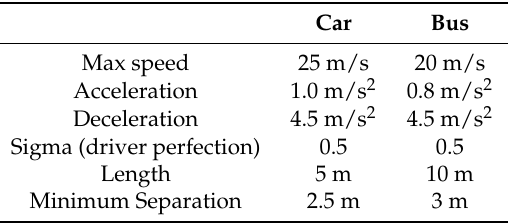
Table 1. SUMO simulation